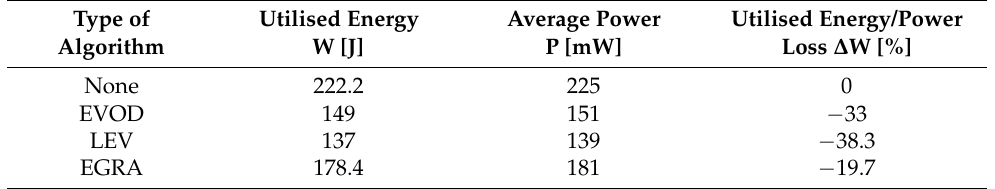
Table 1. The comparison of three proposed algorithms for balancing the charge that flows between the rail and the ground (for the measurements shown in Figure